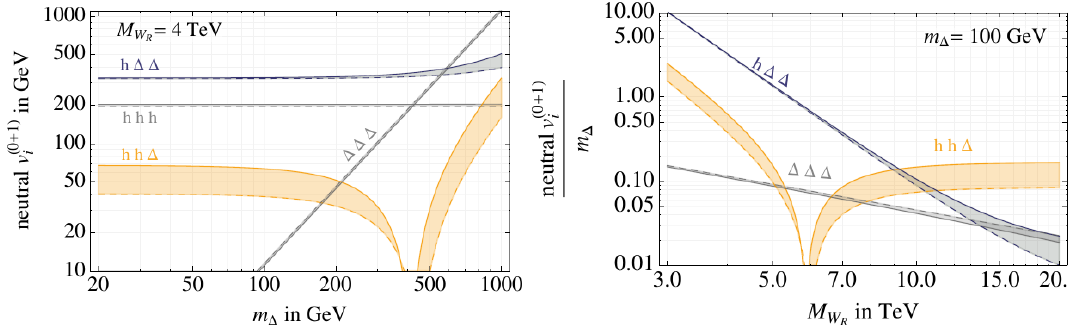
Figure 11 . Left: Neutral Higgs trilinear couplings at one loop, obeying the vacuum stability condition in (A.24), s (cid:18) 2 (0 : 05 ; 0 : 1), M W = 4 TeV ; m H = 17 TeV and r ++ = 0 : 3 (see text). R The blue and yellow regions are the v h (cid:1)(cid:1) and v hh (cid:1) vertices that set the pair-production and associated production rates in (cid:12)gure 4. Right: Neutral tri-linear dependence on M W m (cid:1) = 100 GeV, all values as on the left but normalized to m (cid:1) . In short, when s 6 = 0, the v (1) is reduced by c 3 while the other three receive a signi(cid:12)cant (cid:18) (cid:18) (cid:1)(cid:1)(cid:1) addition (cid:1) v (1) / s 1 ; 2 ; 3 hhh;hh (cid:1) ;h (cid:1)(cid:1)